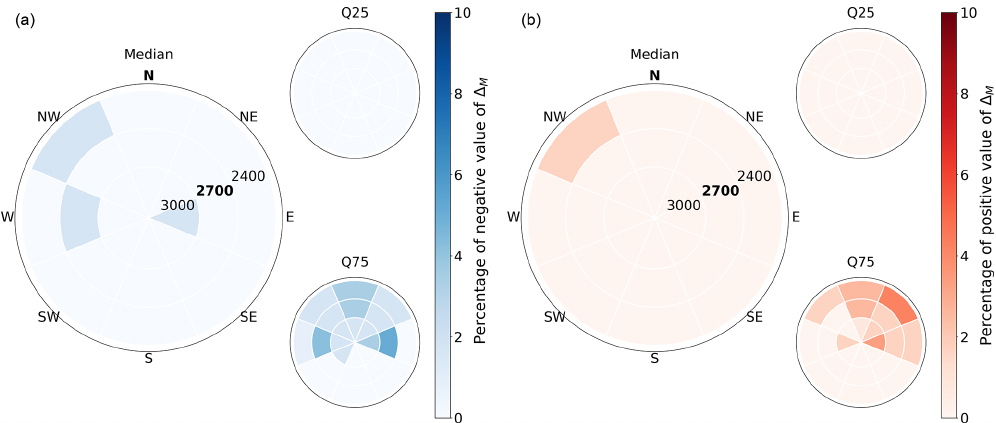
Figure 11. Proportion of days with (a) a more stable and (b) a less stable snowpack when contaminated with dust for each of the eight slope aspects and for three different elevations: 2400, 2700 and 3000m. The analysis covers the period from the dust event to 6 April 2018. The (cid:49) M index is introduced in Sect. 2.3.1 and represents the difference in dry-snow stability between dust and no-dust simulations. The biggest pie plot corresponds to the median of the ensemble members and the small pie plots to the first (Q25) and third (Q75) quartiles of ensemble